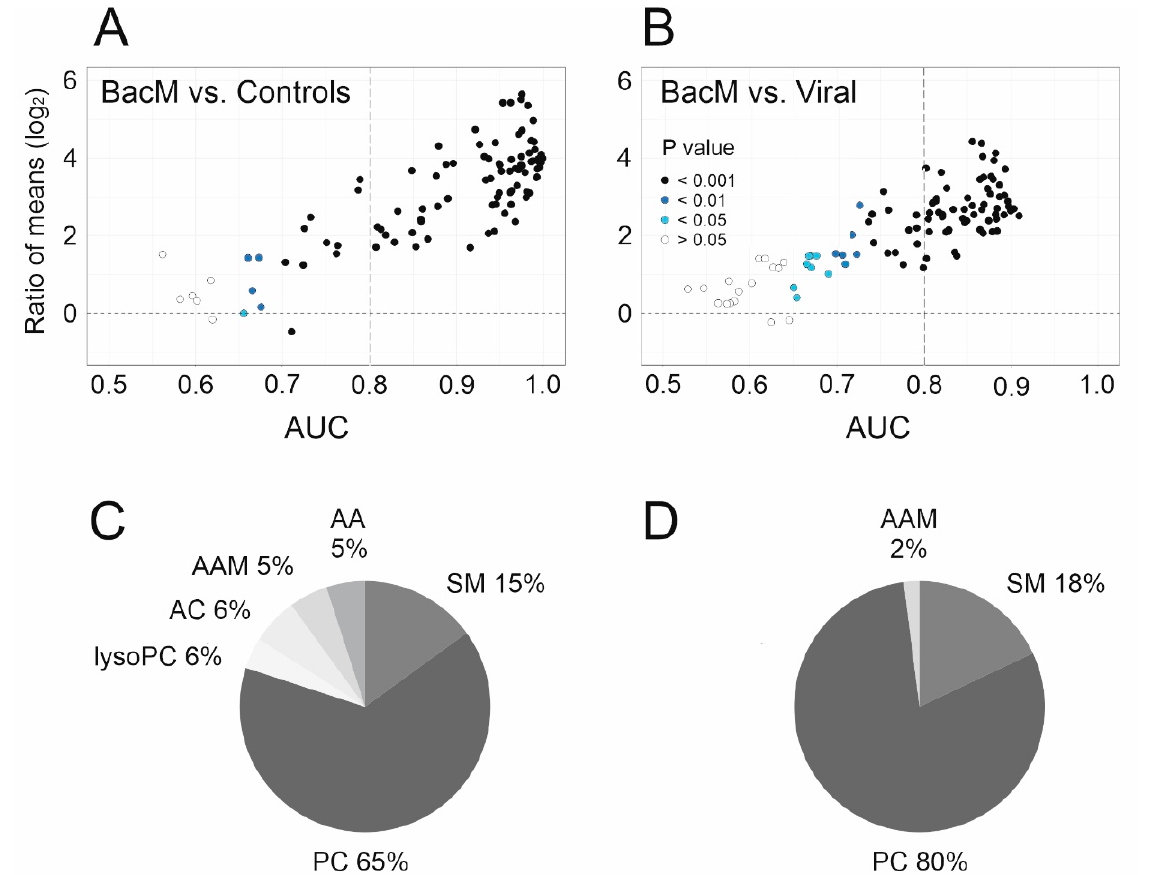
Figure 2. Phosphatidylcholines have the greatest biomarker potential to distinguish bacterial meningitis from viral CNS infections. ( A , B ). Dispersion plots based on binary receiver operating characteristic (ROC) curve analysis of the same 100 CSF metabolites as used for Figure 1. For each pair-wise comparison, ratio of mean concentrations (“fold change”, Bacterial meningitis/Controls and Bacterial meningitis/Viral CNS Infections) is plotted on the y-axis, area under the ROC curve (AUC) along the x-axis; each circle represents one metabolite, with the fill color indicating asymptotic significance of the ROC curve. The y-axis label of A also applies to B. ( A ) Bacterial meningitis/Controls. ( B ) Bacterial meningitis/Viral CNS infections. ( C , D ). Percentages of all biomarkers (AUC > 0.8, p < 0.05, lower CI > 0.5) that originate from each of the 6 metabolite subclasses. ( C ) Bacterial meningitis/Controls; ( D ) Bacterial meningitis/Viral CNS